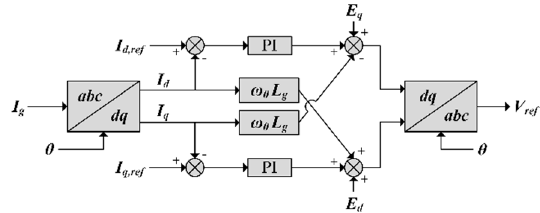
Figure 7. Inner control loop of the VSC.